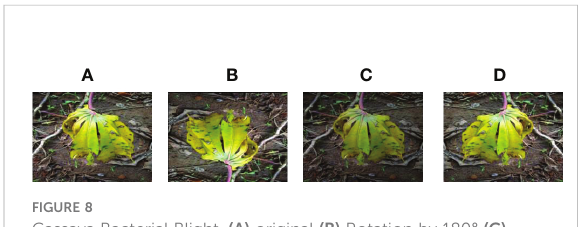
FIGURE 8 Cassava Bacterial Blight. (A) original (B) Rotation by 180° (C) Brightness reduction (D) Horizontal fl ipping.